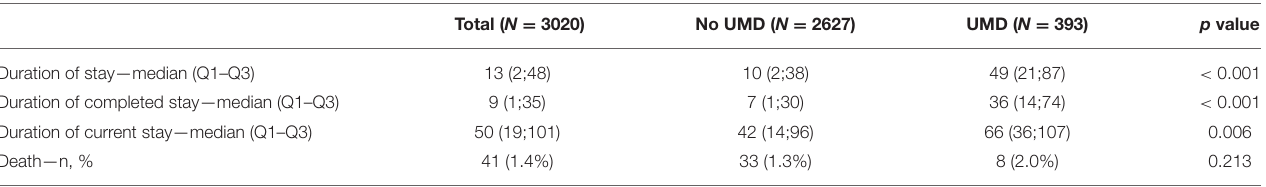
TABLE 2 | Duration of hospitalization (in months) and death during hospitalization for patients found not criminally responsible on account of mental disorder and referred to psychiatric hospitalization in France